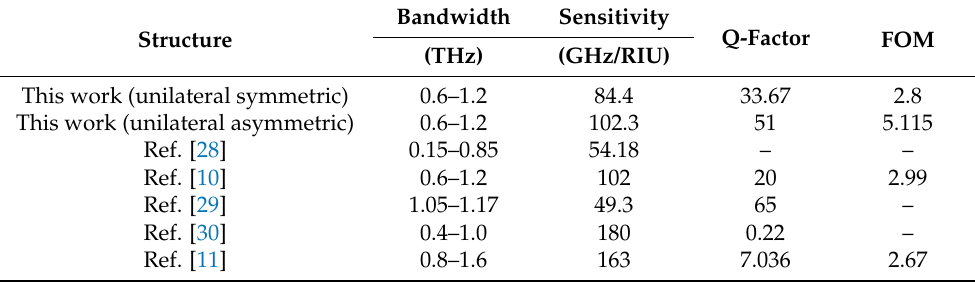
Table 1. Performance comparison of various terahertz metamaterial sensors. Bandwidth Structure